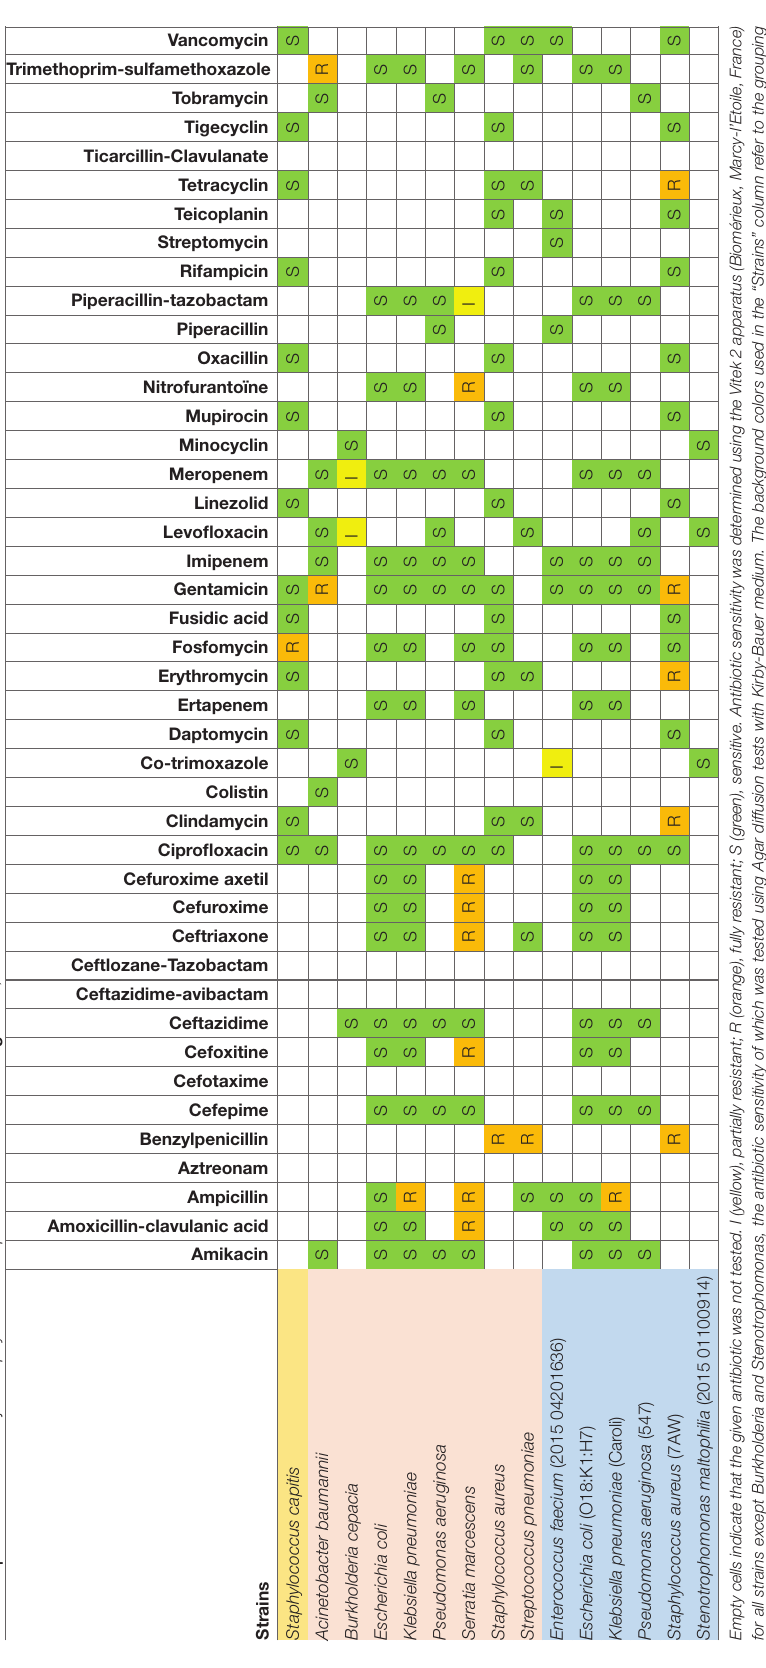
Benzylpenicillin